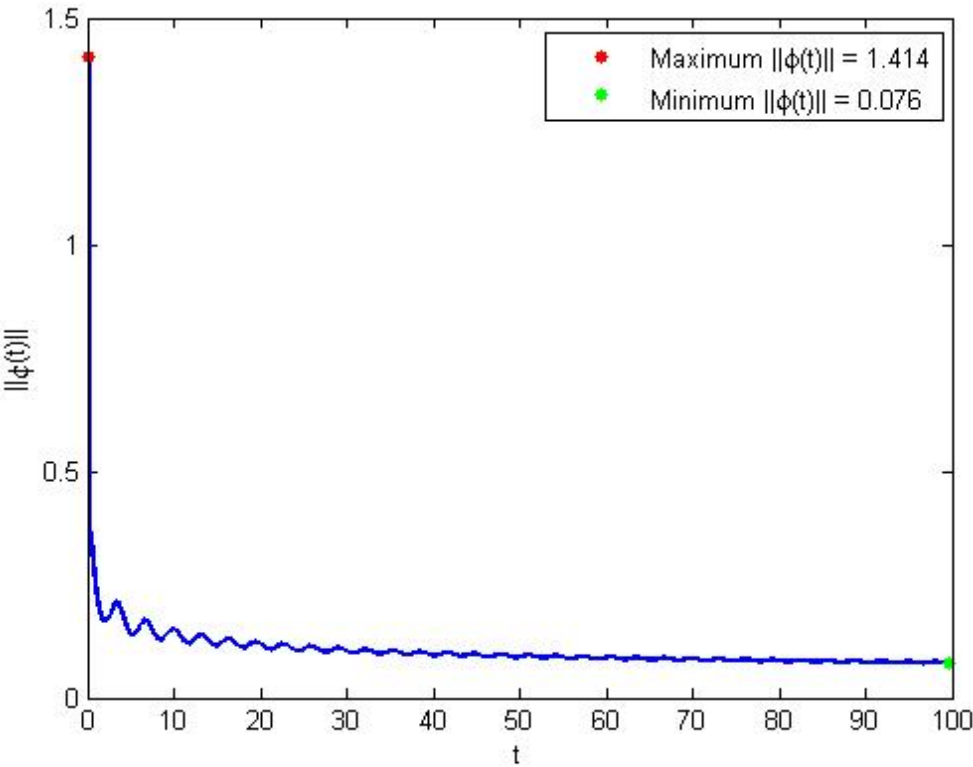
Figure 15. || e ( t ) || for system (10), with α = 0.5, ρ = 0.5, and w ( t ) = [ 2 sin ( t )] T . Figure 15. ‖𝑒(𝑡)‖ for system (10), with 𝛼 = 0.5 , 𝜌 = 0.5, and 𝑤(𝑡) = [2 𝑠𝑖𝑛(𝑡)] 𝑇 .